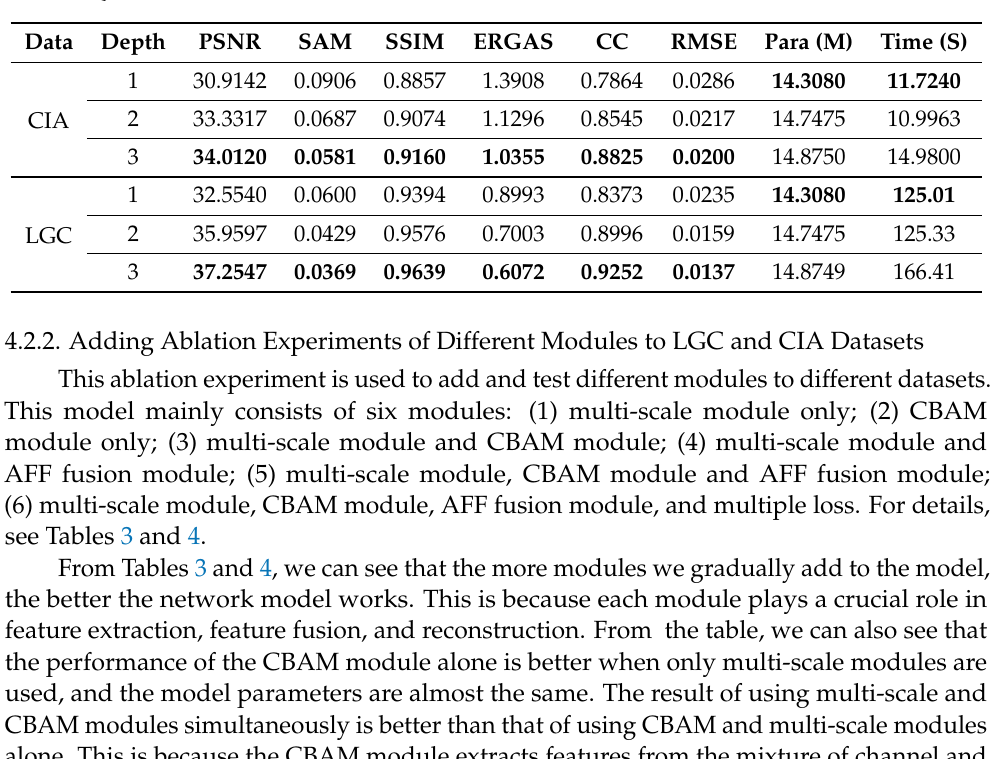
Table 2. Quantitative Results of Multiscale on CIA and LGC